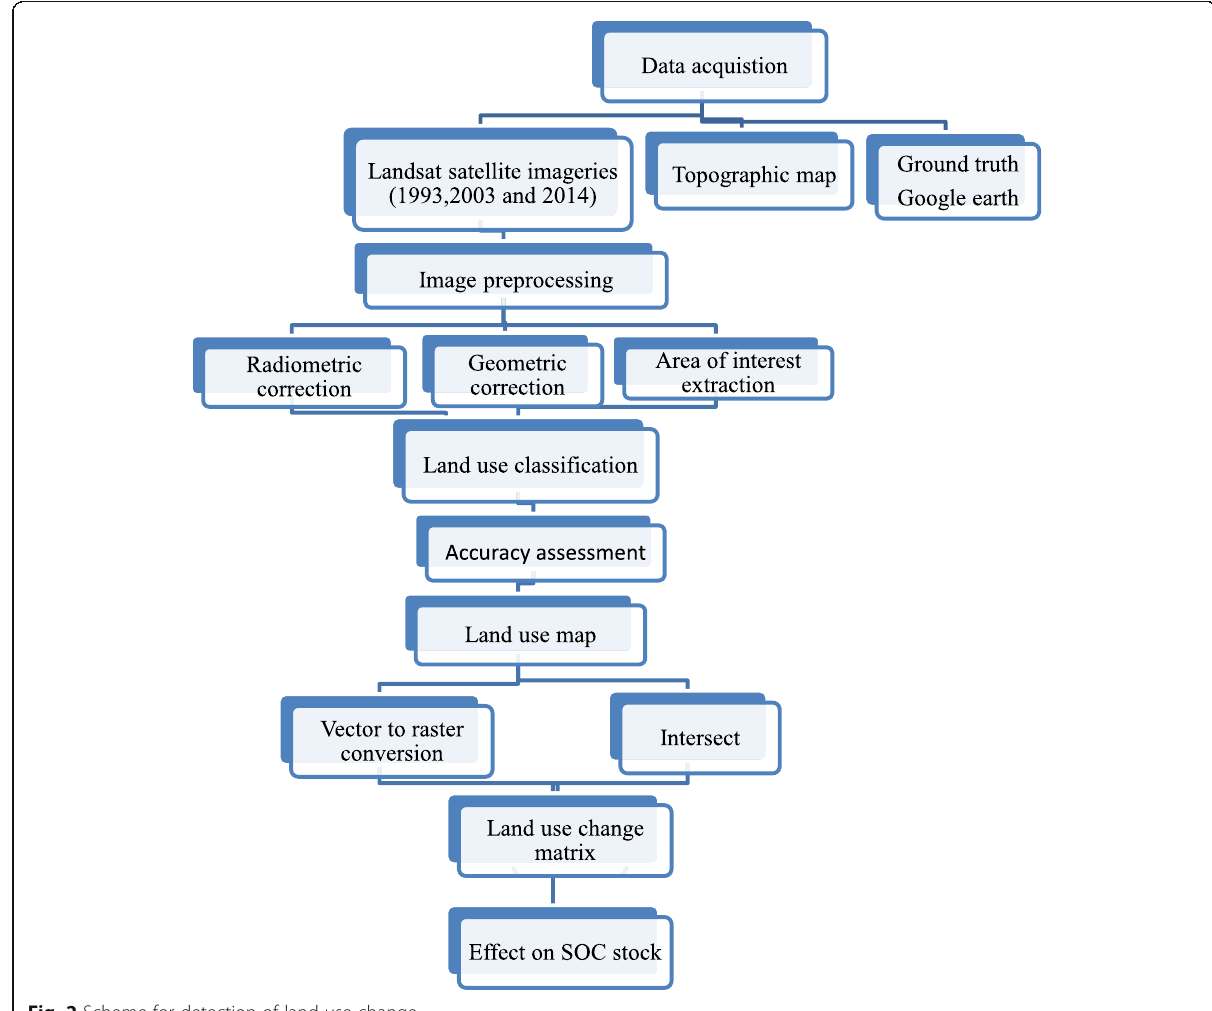
Fig. 2 Scheme for detection of land use